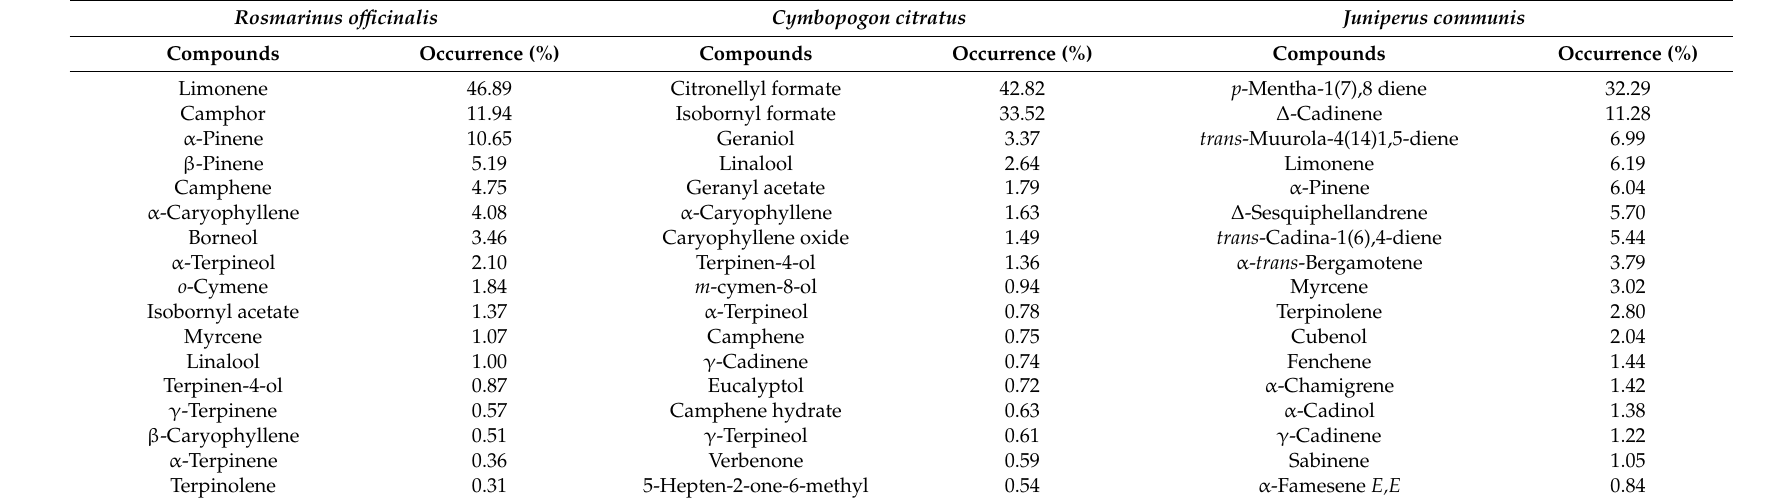
Table 4. Chemical composition (% of compound) of the R. officinalis , C. citratus and J. communis